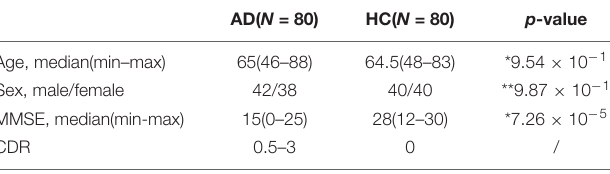
TABLE 1 | Clinical characteristics of AD patients and HC.